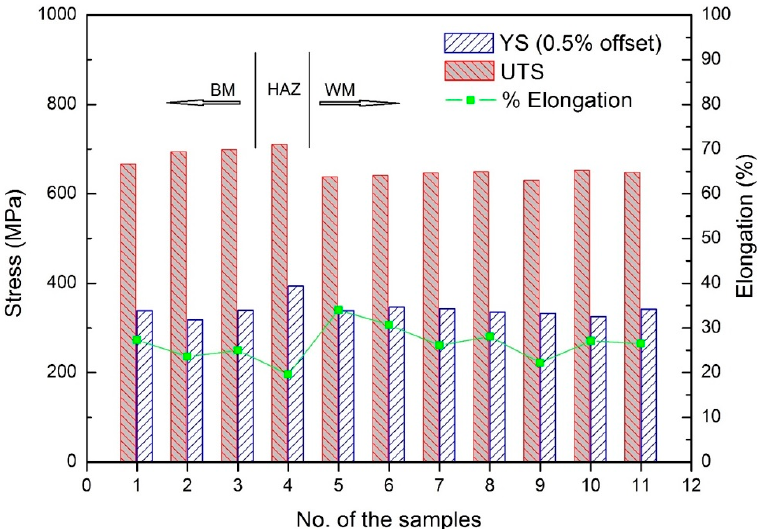
Figure 9. Location effect on mechanical properties of the NAB component produced by WAAM.